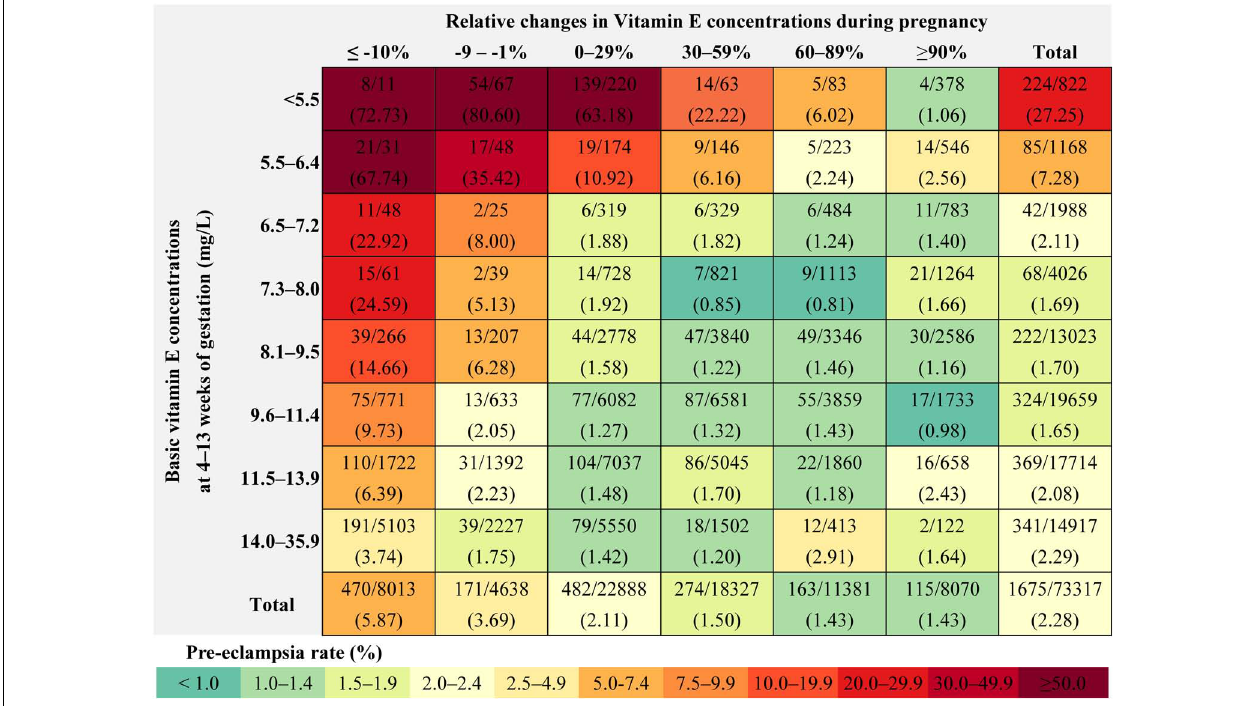
vitamin E concentrations of < 5.5 mg/L and 5.5–6.4 mg/L in the first trimester had 29.56-fold (95%CI, 22.92–38.12) and